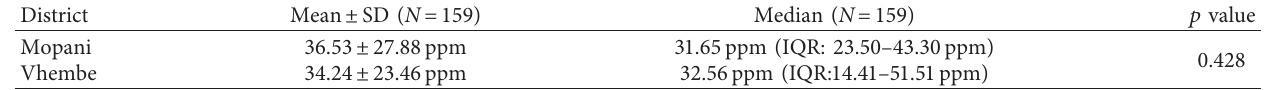
Table 2: Iodine content mean values for Mopani and Vhembe districts.